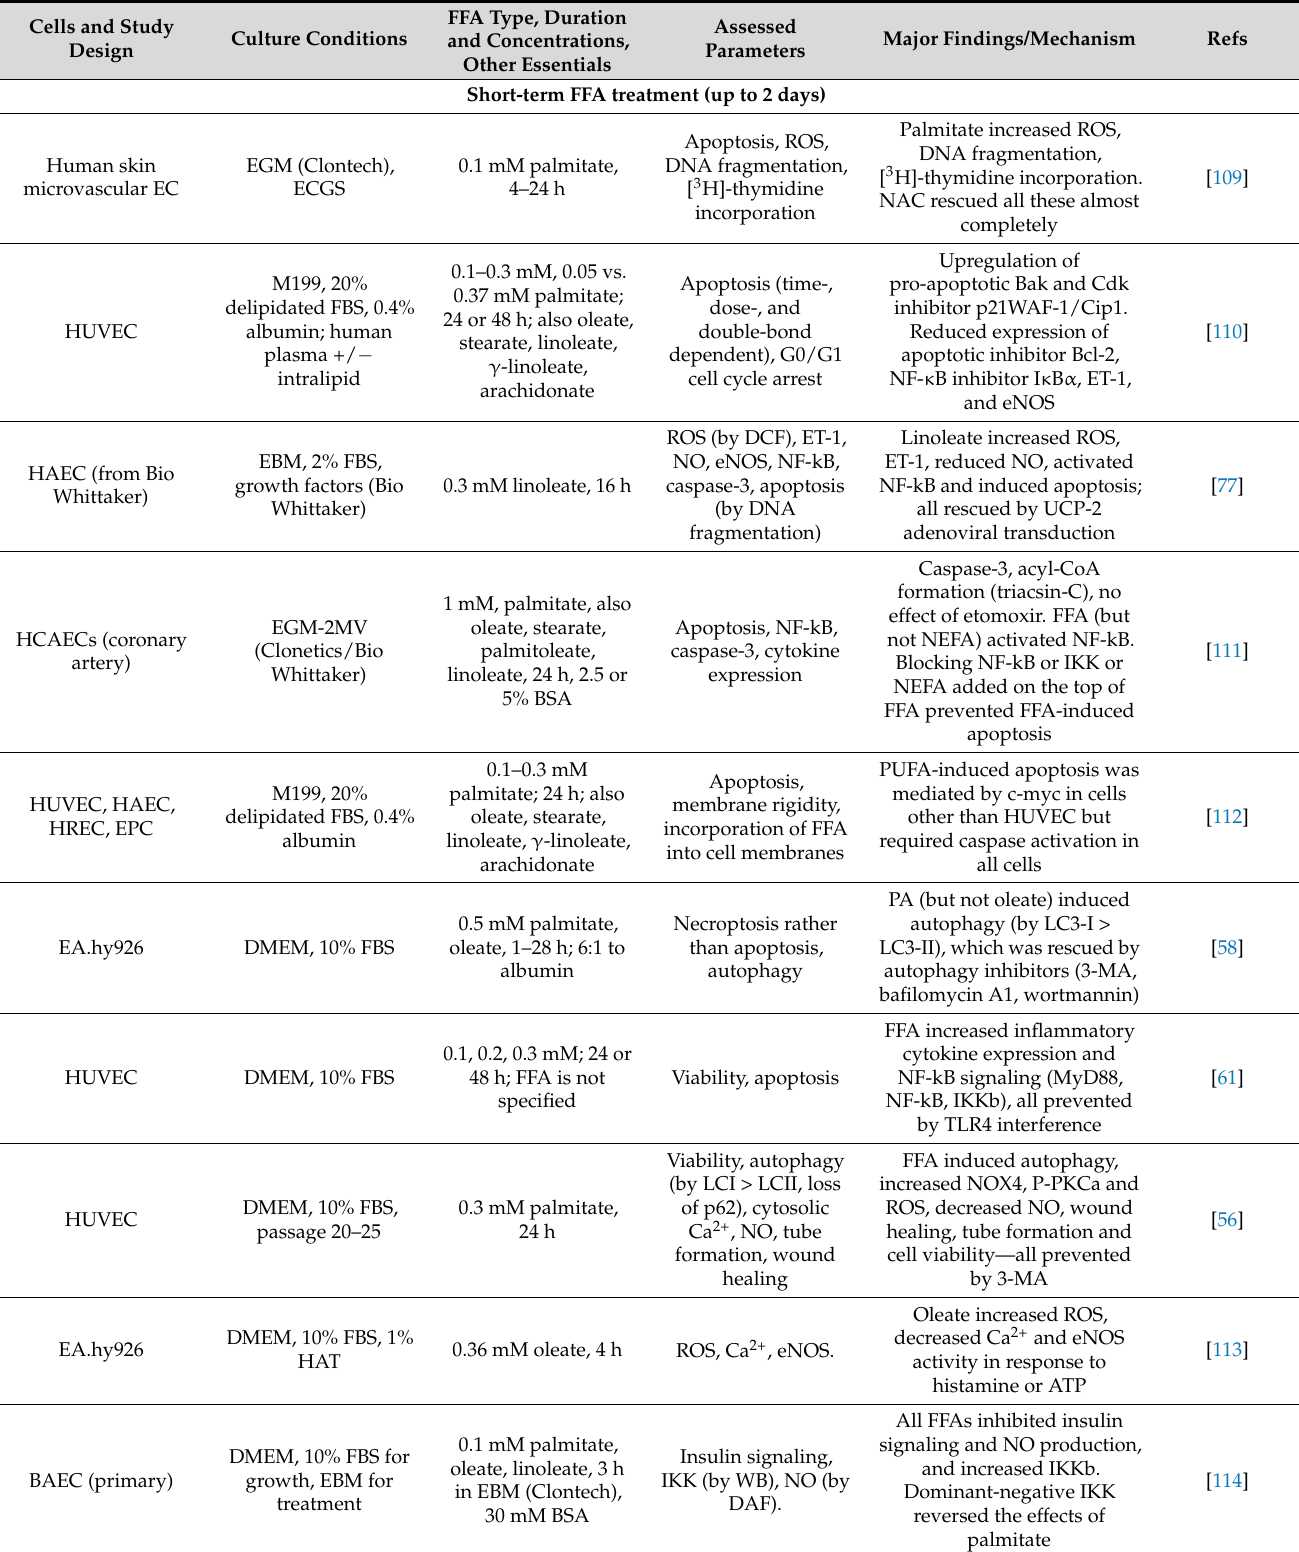
Table A2. Summary of the outcomes of FFA action on endothelial cells (experimental hyperlipidemia) in